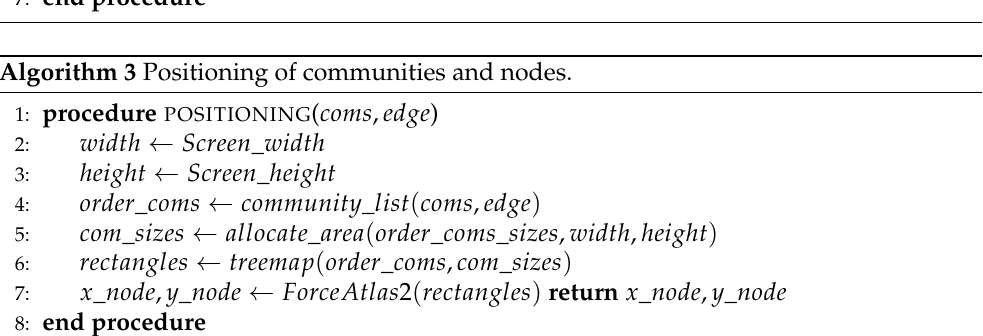
Algorithm 3 Positioning of communities and